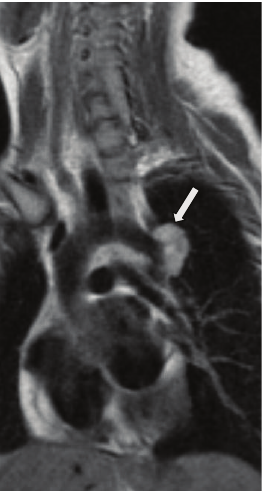
Figure 2: The pseudoaneurysm with thrombus at the Dacron patch repair site found during a routine antenatal